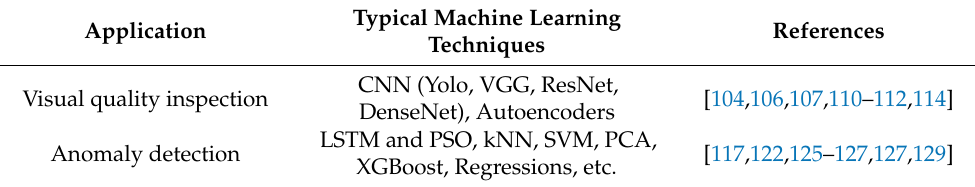
Table 3. Summary of applications of machine learning techniques in IIoT quality control.